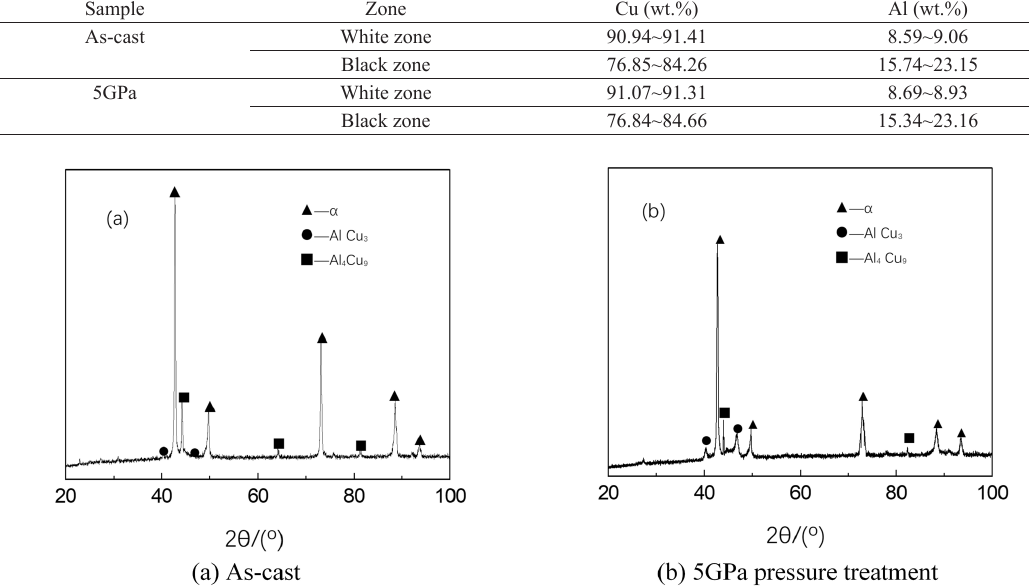
Fig.2 - XRD patterns of Cu-Al alloy before and after high pressure treatment